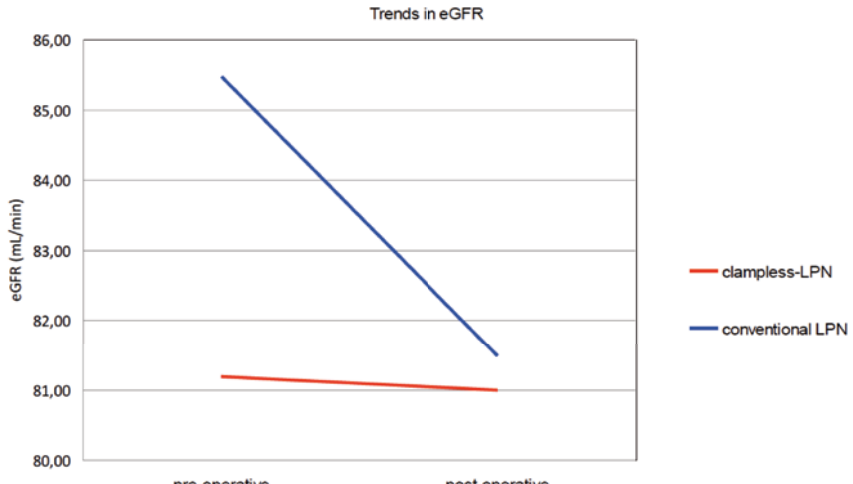
Figure 3 - Plot lines showing the trend between pre-operative and post-operative estimated Glomerular Filtration Rate (eGFR). Red Line: clampless-laparoscopic partial nephrectomy (LPN); Blue Line: conventional